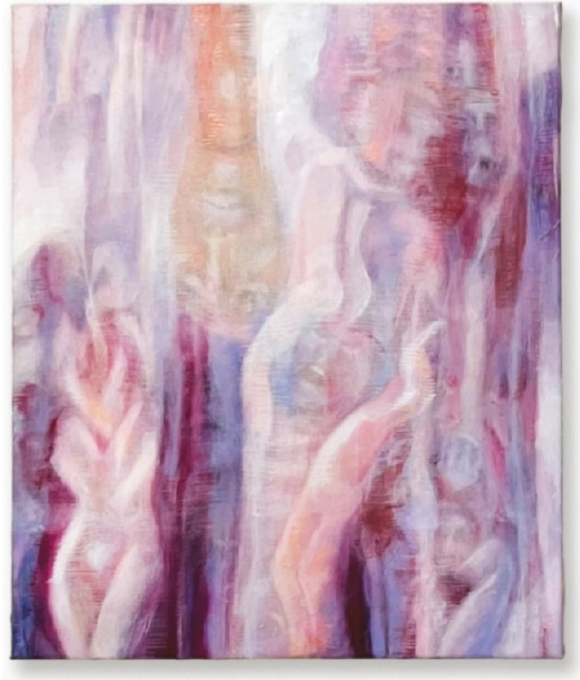
Figure 10. Bracha L. Ettinger. “Annunciation-Birthing-Pieta n.3”, 2017–2021, oil on canvas. (C) Cour- tesy of the artist.